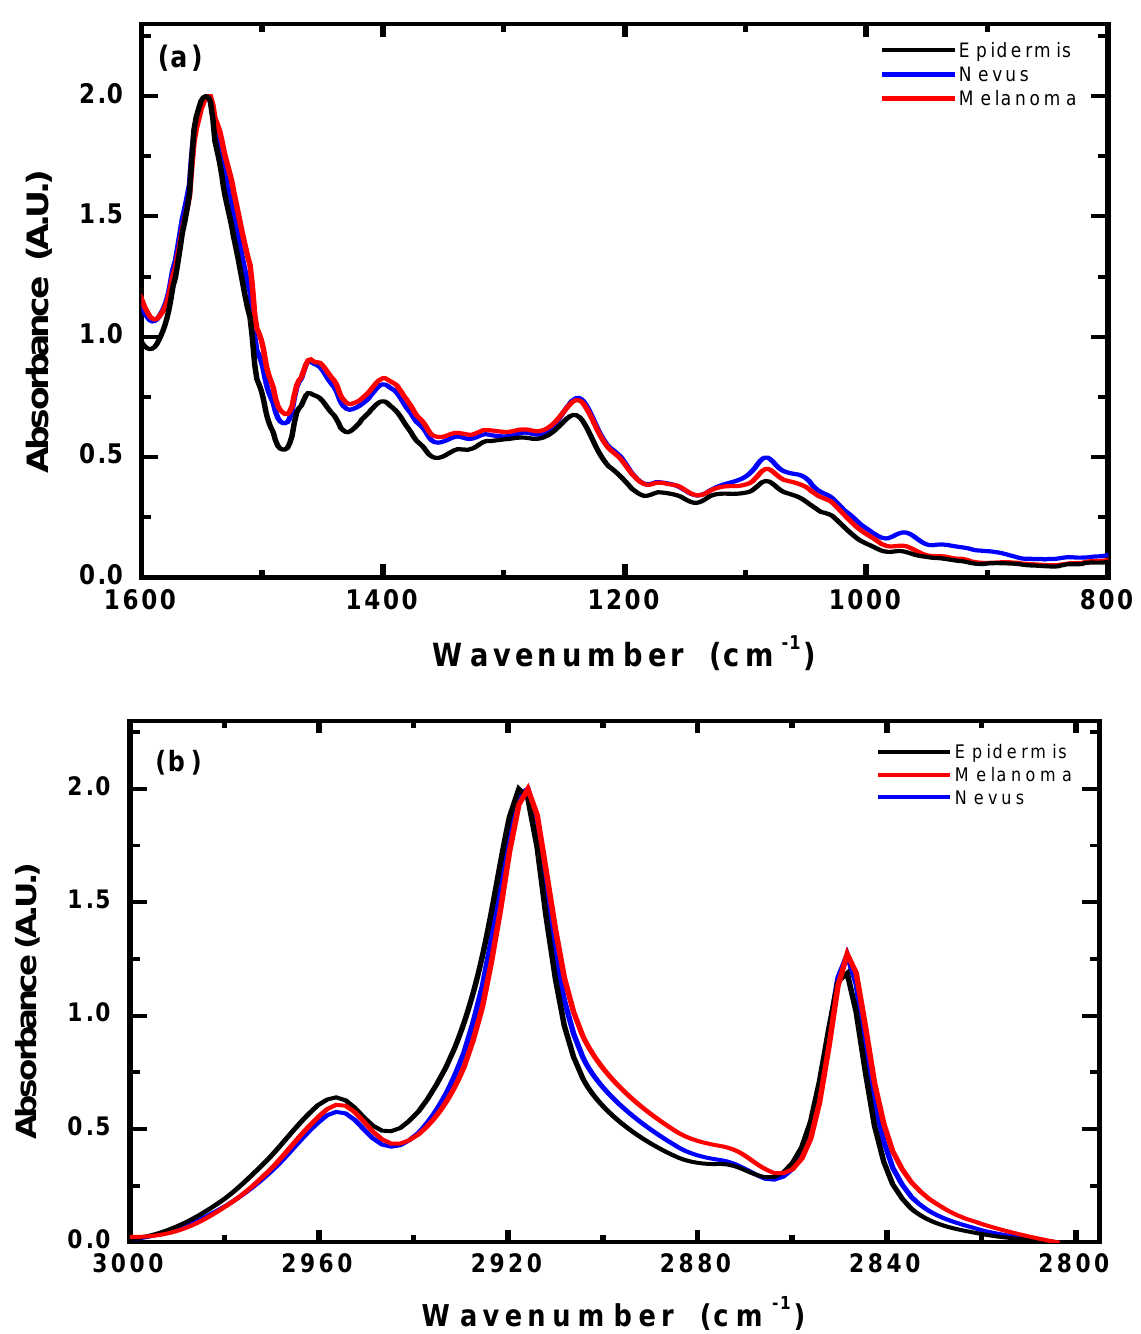
FIGURE 1. FTIR-MSP spectra of (black) epidermis, (blue) compound nevus, and (red) surface spreading melanoma in the region (a) 800– 1600 cm –1 and (b) 2800–3100 cm –1 . The spectra between 2800–3100 cm –1 are presented after a second baseline correction in the region and min-max